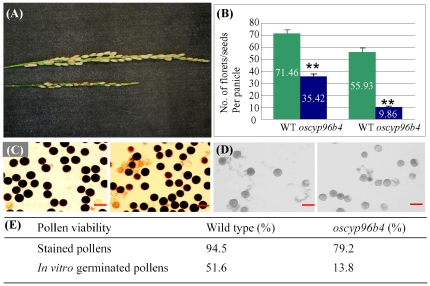
Defects of oscyp96B4 at the reproductive stage.(A) Panicles in WT (top) and mutant (bottom). (B) Florets and seeds in WT (green) and mutant (blue). The symbols “**” indicate significant differences between WT and the mutant plants at P<0.01 by t-test. (C) Pollens stained with I2/KI in WT (left) and mutant (right). Starch can be stained by the I2/KI solution and the starch content in pollen grains can serve as an indicator of viability. (D) Germinated pollens in WT (left) and mutant (right). Germination rate of pollens in WT is higher than that in the mutant. (E) Pollen viability in WT and mutant. Bars in (C) and (D) = 50 μm.